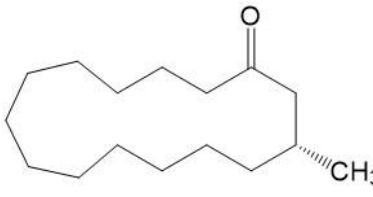
Figure 1. Chemical structure of muscone.